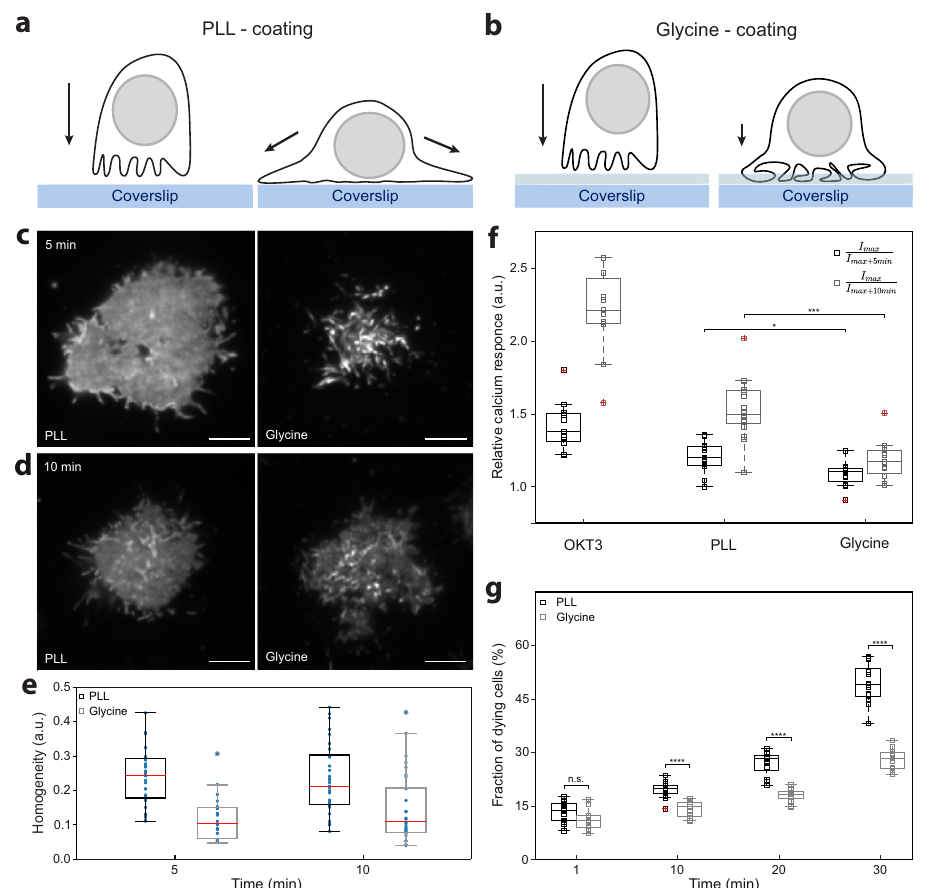
Fig. 1 Coating of coverslips with glycine better preserves cell surface morphology and resting state of immobilized T cells. a , b Schematic illustration of T-cell landing on PLL- (left panels) and glycine-coated coverslips (right panels). The arrows indicate forces in fl uencing the cell on the coated coverslip. The g-force is the sole force affecting T cells on glycine. T cells on PLL are further stretched due to electrostatic interactions of the surface molecules with PLL. The blue stripes represent glass coverslip, the light blue stripes above represent the glycine layer (not to scale). c , d Live-cell TIRF microscopy of CD4-GFP in Jurkat cells landing on PLL- (left panels) or glycine-coated (right panels) coverslips measured at 37 °C. Representative contact morphology is shown for cells 5 min ( c ) and 10 min ( d ) after addition of the cell suspension to coverslips. e Graph showing signal homogeneity of cell contacts on PLL- and glycine- coated coverslips as in c and d . Signal homogeneity was quanti fi ed according to ref. 91 (see “ Methods ” and Supplementary Data for more details). In total, 31 cells for PLL 5min , 21 cells for Glycine 5min , 32 cells for PLL 10min and 29 cells for Glycine 10min were analyzed. Blue dots represent values from individual cells, red lines median values, boxes indicate upper and lower quartile of data and outliers are circled. Statistical signi fi cance was evaluated using one-way ANOVA test; p 5min < 10 − 5 , p 10min ≤ 0.0025. f Calcium response induced by the interaction of Jurkat cells with coverslips coated with stimulating antibody (anti-CD3 ε ; OKT3), PLL or glycine as indicated by the changes in the fl uorescence of ultrafast genetically encoded calcium sensor GCaMP6f u at 5 min (black bars; I max / I max + 5min ) and 10 min (gray bars; I max / I max + 10min ) after the maximal stimulation of cells ( I max ). The extent of calcium response was calculated from the signal decay after cell spreading on stimulating surfaces (see “ Methods ” and Supplementary Data for more details). Relative calcium response equal 1 indicates no stimulation. Higher values indicate measured stimulation of cells. Small squares represent values calculated for individual cells; solid lines median values, boxes indicate upper and lower quartile of data and outliers are marked with a red cross. Statistical signi fi cance was evaluated using one-way ANOVA test; * p < 0.05 or *** p < 0.001. Five examples of full signal traces together with graphical representation of data processing are shown in Supplementary Fig. S7. g Viability of Jurkat cells interacting with coverslips coated with PLL- (black bars) or glycine-coated (gray bars) coverslips. Dying cells were de fi ned as a fraction of 7-aminoactinomycin-positive cells within the imaged area using wide- fi eld microscopy (see “ Methods ” and Supplementary Data for more details). Values at 1 min represent the starting point for the analysis — a minimal period required for cells to land at the optical surface. Small squares represent individual measurements, solid lines median values, boxes indicate upper and lower quartile of data and outliers are marked with a red cross. Statistical signi fi cance was evaluated using unpaired t -test with unequal variances (Satterthwaite ’ s approximation); **** p < 0.0001, n.s. (not signi fi cant). Scale bars, 5 μ receptors was performed by standard immuno fl uorescence pro- tocols using directly labeled, highly speci fi c primary antibodies to avoid arti fi cial clustering by high level crosslinking with sec- ondary antibodies 60 – 62 . To prevent visualization of intracellular molecules, fi xed Jurkat cells were labeled in the absence of membrane permeabilization.